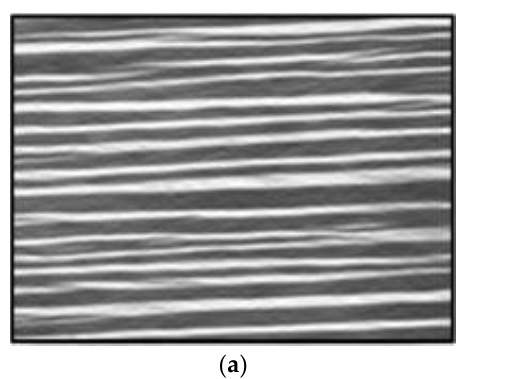
) 3 and T °C, and how it depends on the nematic order parameter. Figure 2. ( a ) [40], shows the correlation between r = ( 𝐿 𝐿 𝐼𝑆𝑂 Note that L denotes the length of a sample when it is in the nematic phase and LISO denotes the sample’s reference length, when it is 12 °C above threshold temperature of 78 °C. ( b ) shows the good agreement between numerical results and experimental data close to the transition temperature [39]. DT accounts for the random fluctuations added to the threshold temperature, which fluctuates specially (Reprinted with permission from [39,40]).